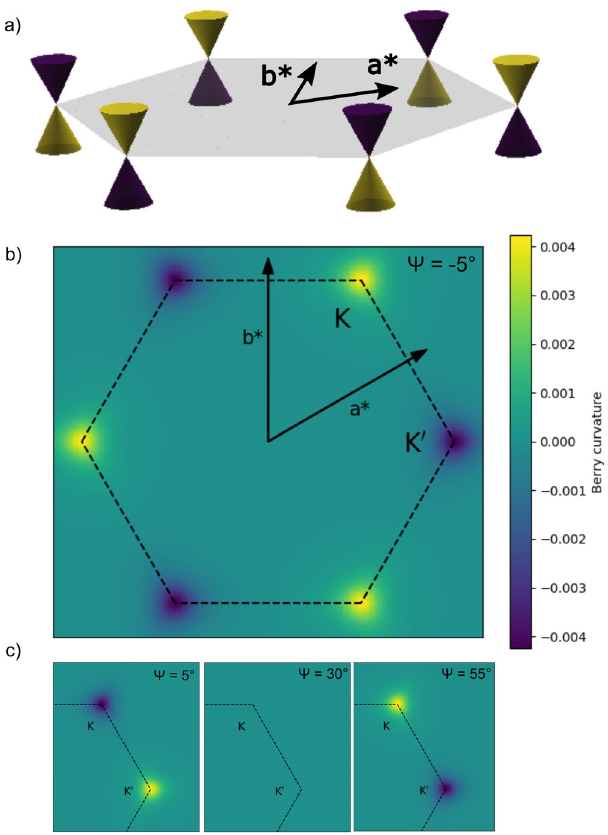
Fig. 4 Berry phase and Berry curvature in the dipolar honeycomb lattice. a The Berry phase associated with the Dirac cone ( Ψ = 0°) is either + π (represented in yellow) or – π (blue). The Berry curvature Ω ( k ) in ErBr 3 calculated for the acoustic magnon branch: b Ψ = − 5°, c Ψ = 5°, Ψ = 30° and Ψ = 55°. Ψ is the angle representing the spin con fi guration. The Brillouin zone boundary is outlined with dashed lines. The color bar shows the magnitude of the Berry